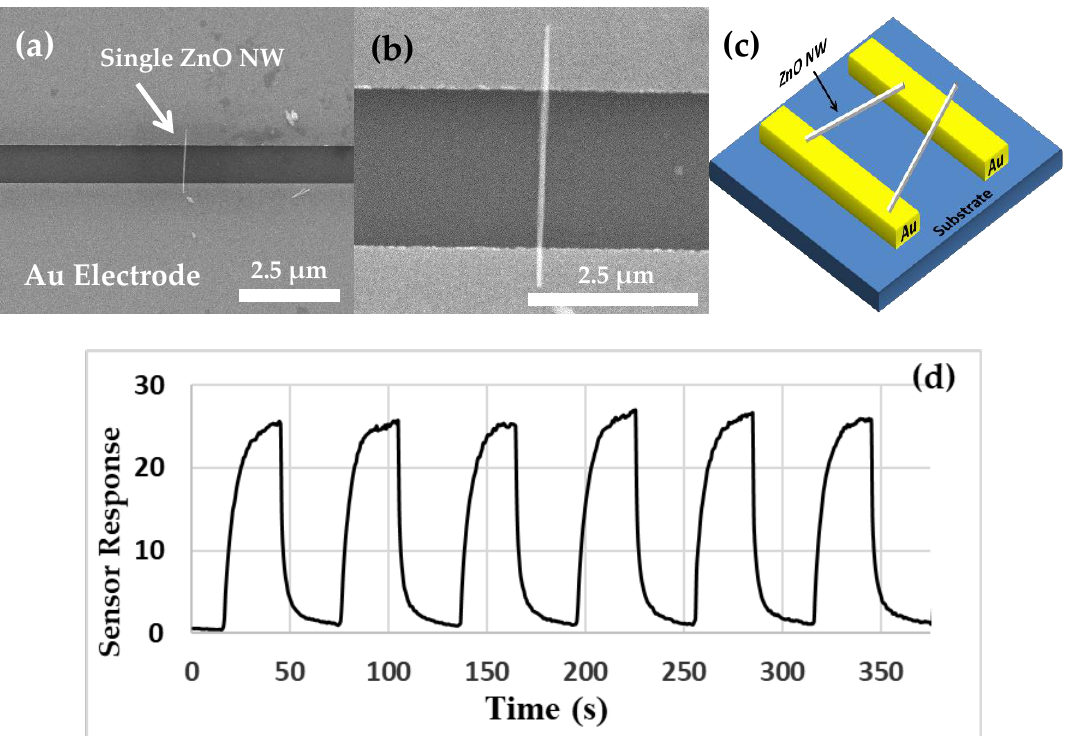
Figure 3. ( a , b ) SEM images (2.5 µm space between the Au electrodes), ( c ) a schematic diagram, and ( d ) the response characteristics of the ZnO SNWs detector to 200 ppm acetone gas.